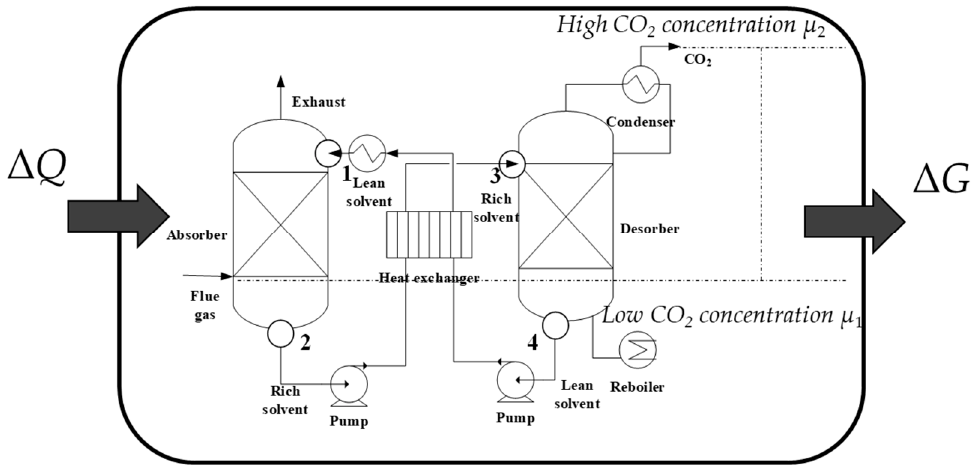
Figure 3. The new concept of energy-efficiency performance of an amine-based absorption cycle.